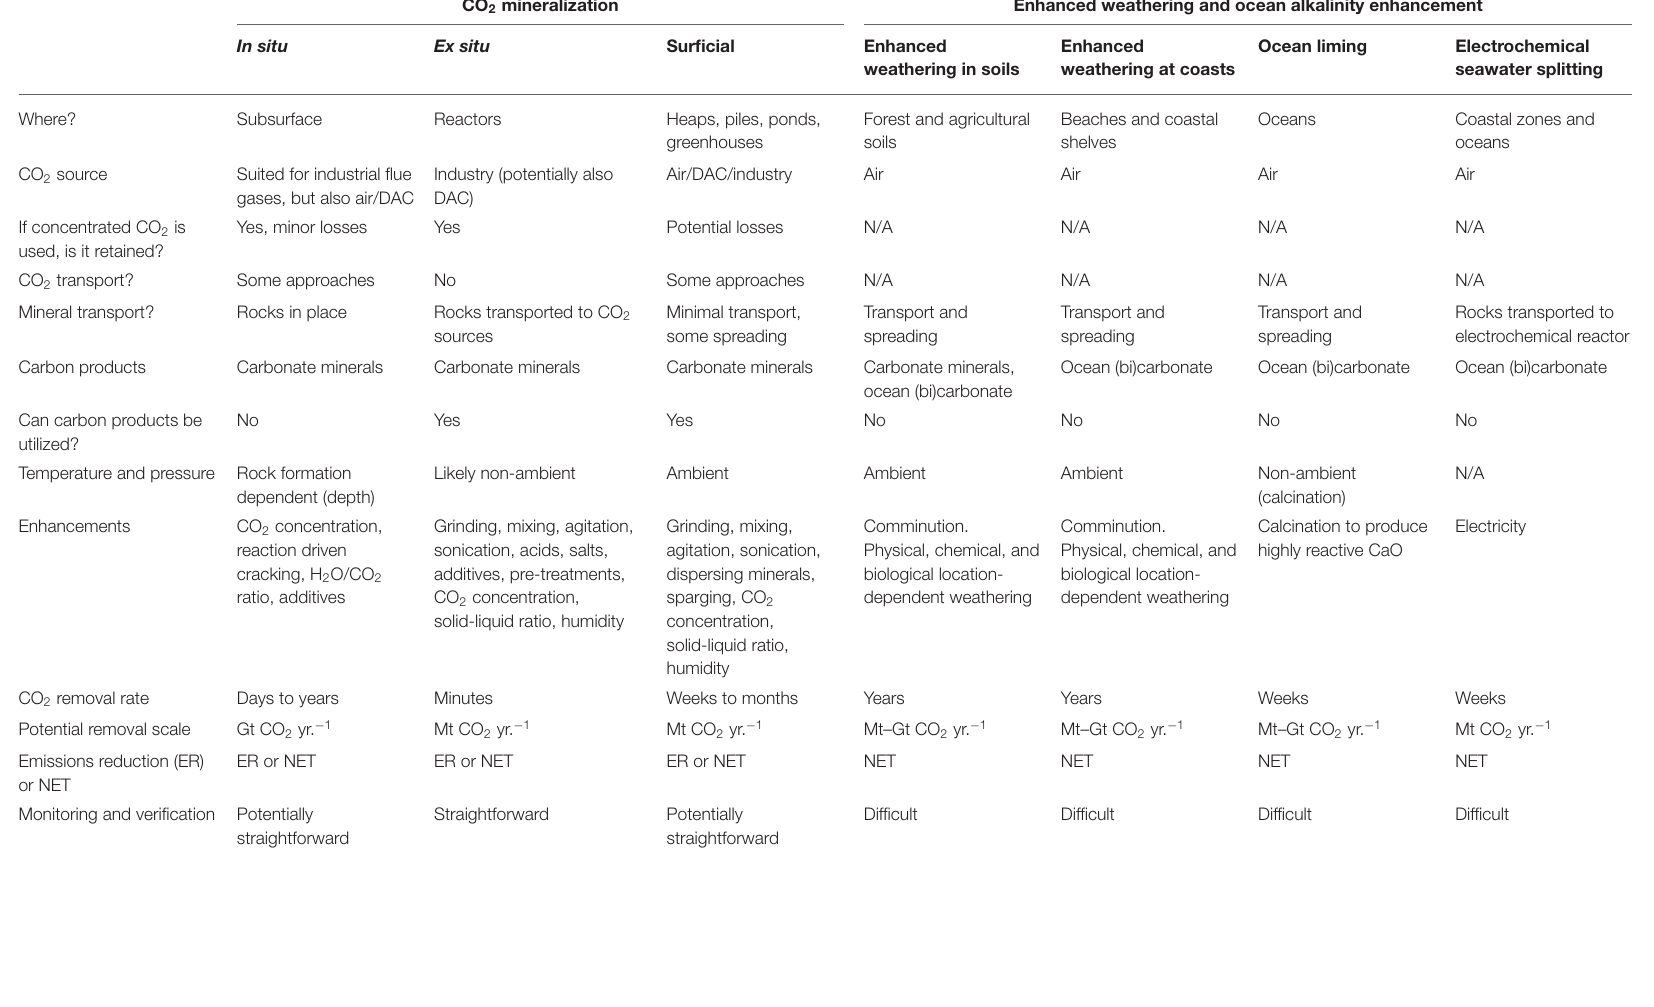
TABLE 3 | Qualitative comparison of geochemical NET